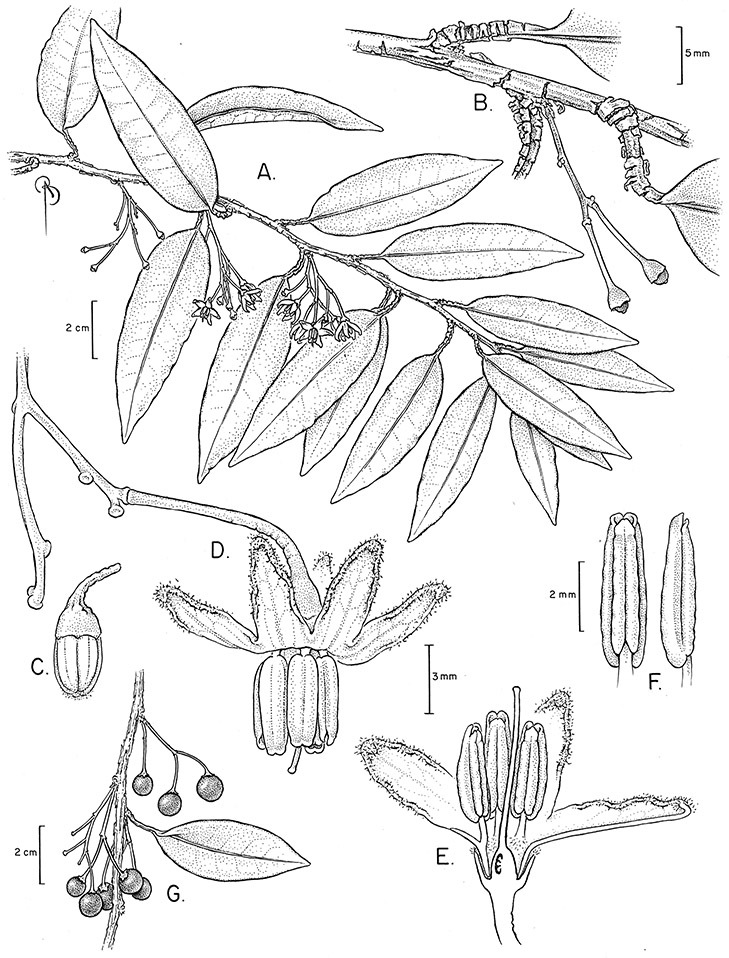
Solanum inodorum Vell. (A–F drawn from Hatschbach 26839
G drawn from Reitz & Klein 5290). Illustration by Bobbi Angell.